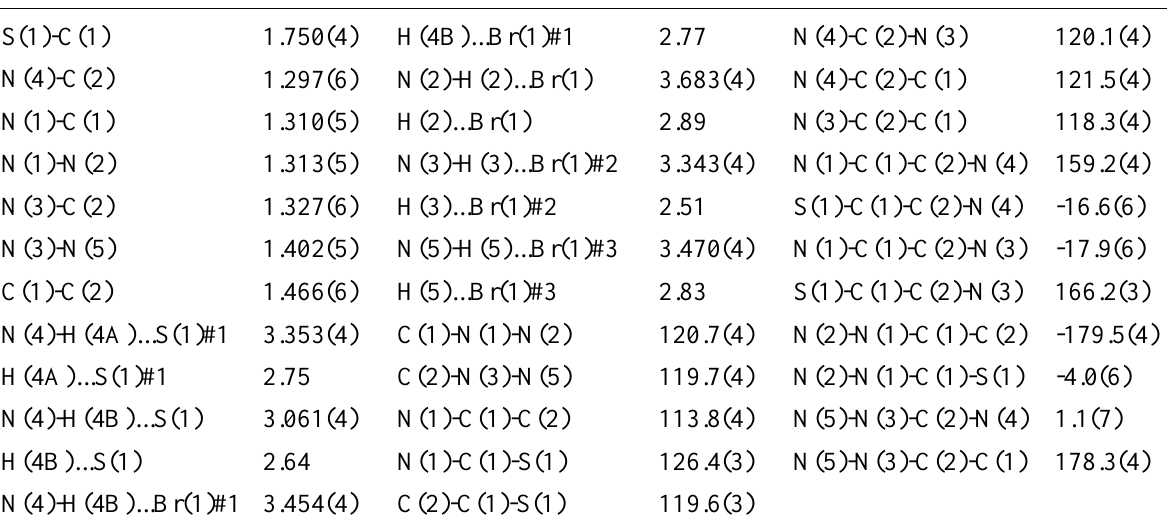
Table 4. Selected bond lengths [in Å], bond angles [in °] and torsion angles [in °] for compound